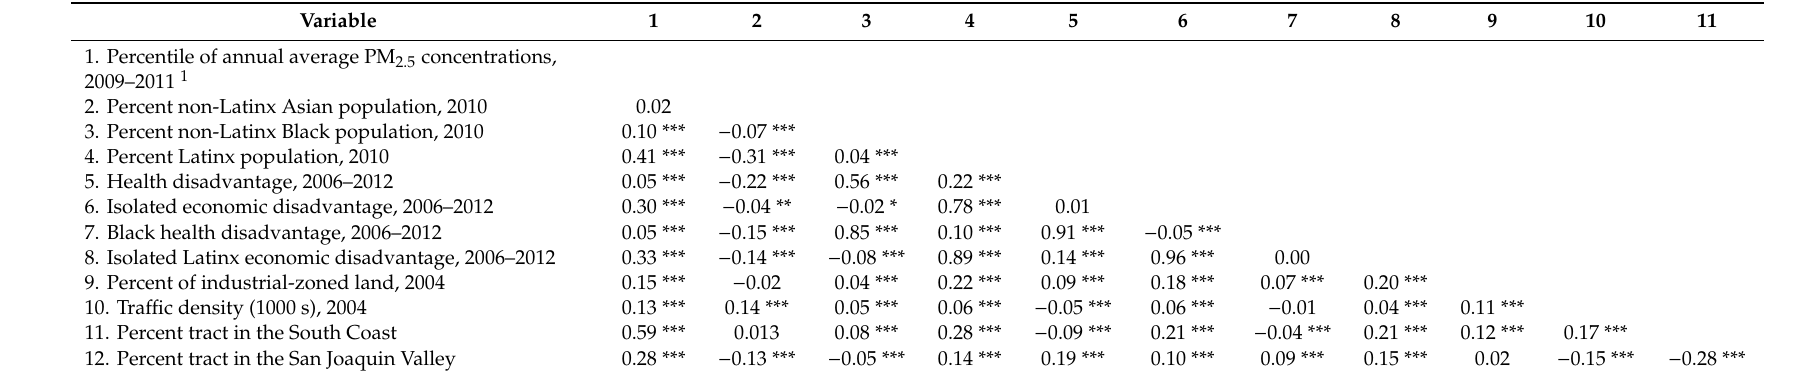
Table A1. Pearson correlation coe ffi cients for variables used in the spatial lag regression analyses (N = 7533 census